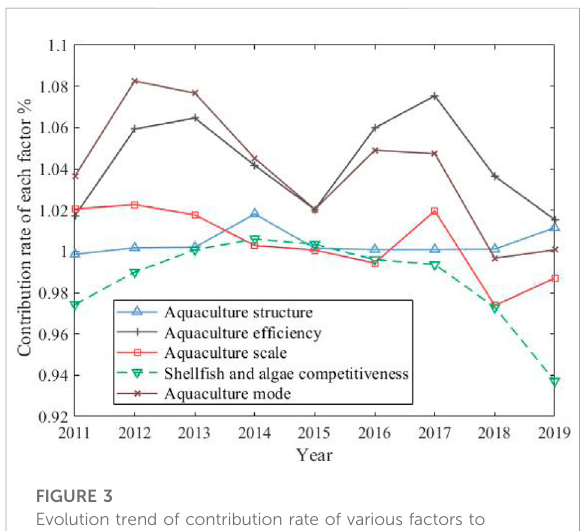
FIGURE 3 Evolution trend of contribution rate of various factors to carbon sink